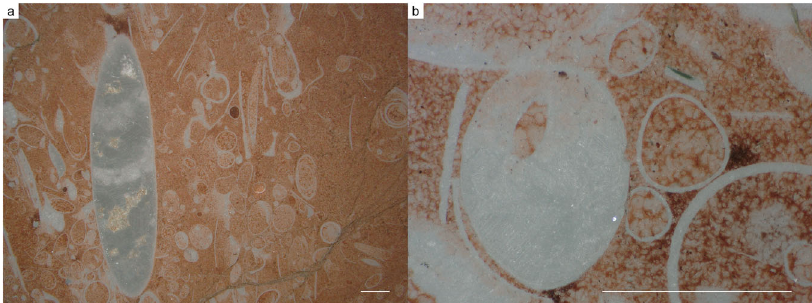
Fig. 4 Thin section images of specimens NFM F-2775 and F-2777. a No. NFM F-2775. Sagittal section. b No. NFM F-2777. Cross section. Scale bar is 1